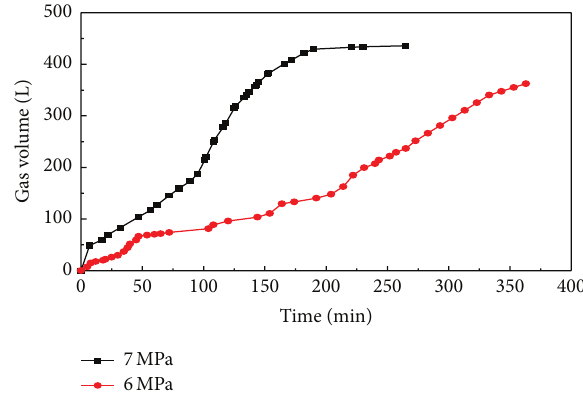
Figure 4: Different isobaric process of hydrate